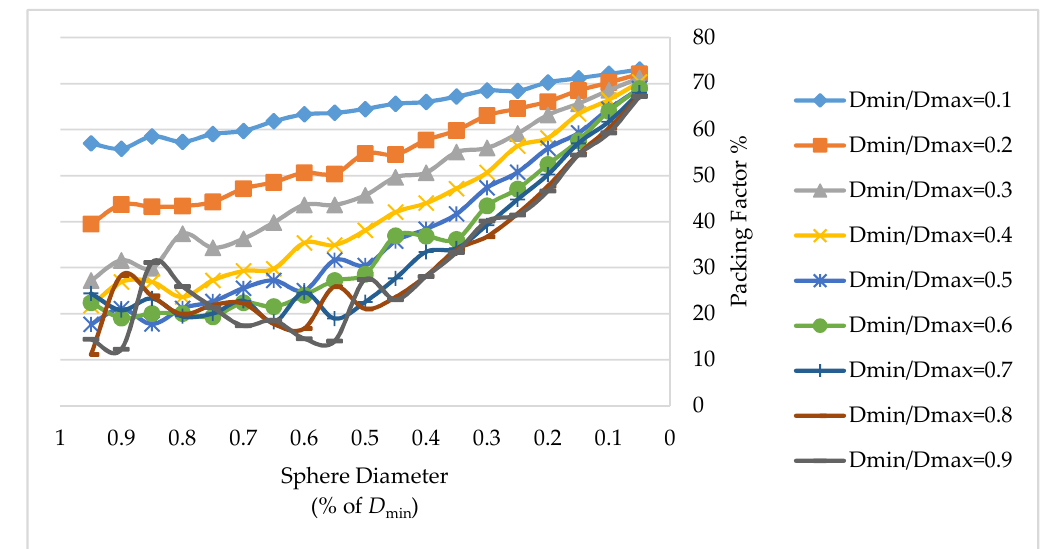
Figure 5. Increase of the packing fraction values in sinusoidal axisymmetric channels with different D min /D max ratios.